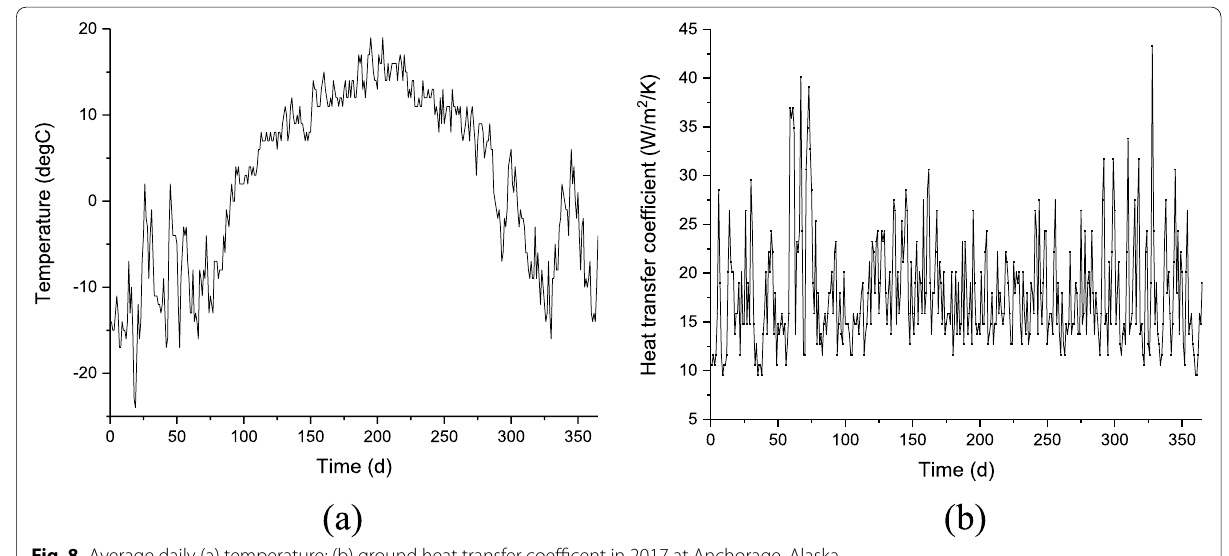
model and pavement structure is subjected to ground freezing. The existing of ice lenses and the expansion of soils leads to development of tensile stress in the pave- ment structure as well as non-uniform frost heave. Fig. 9 summarizes the results of tensile stress and verti- cal displacement distribution on the surface of asphalt layer, base layer and subgrade layer on March 1st, 2017 at Anchorage, Alaska. The results indicate that there are appreciable amount of tensile stress developed in the pavement structure as the results of frost heave.